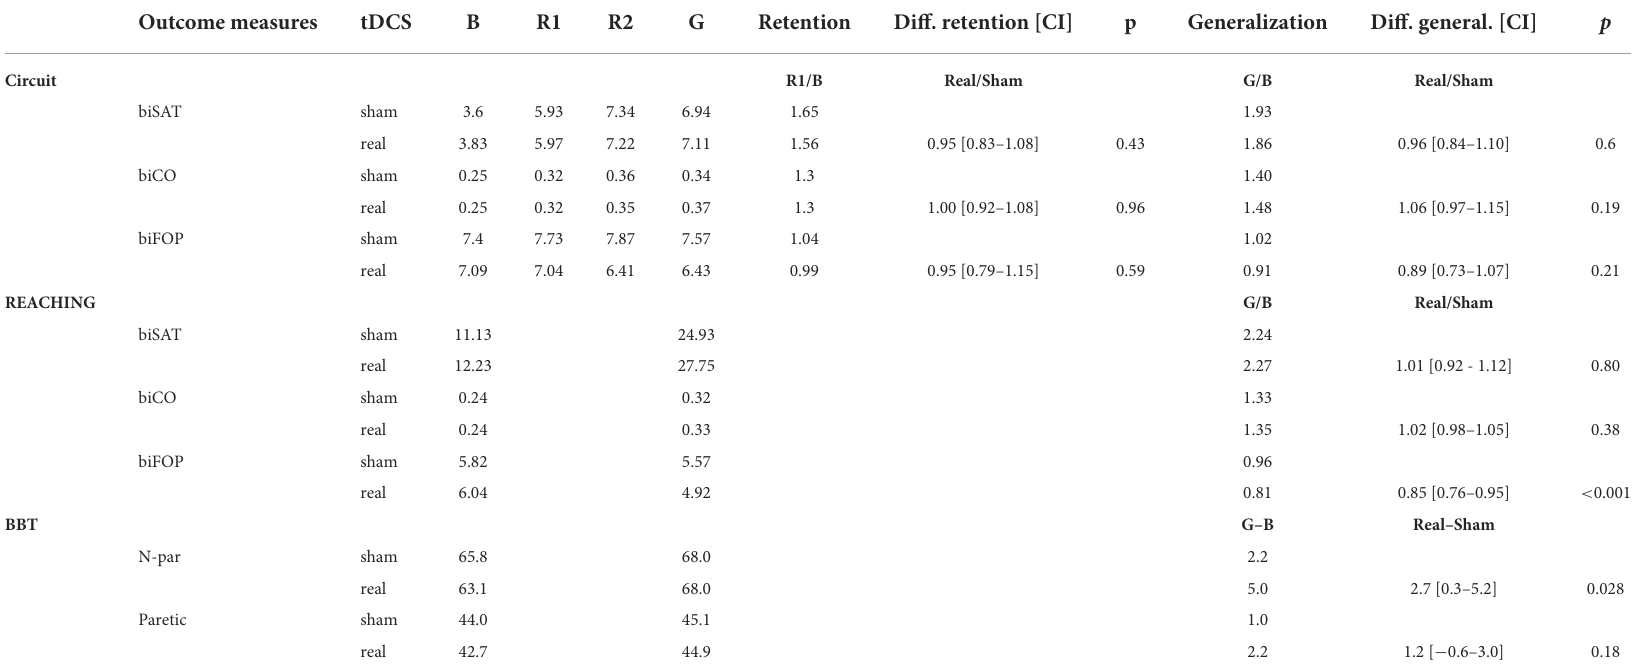
TABLE 3 Patients with stroke: raw data, retention, and